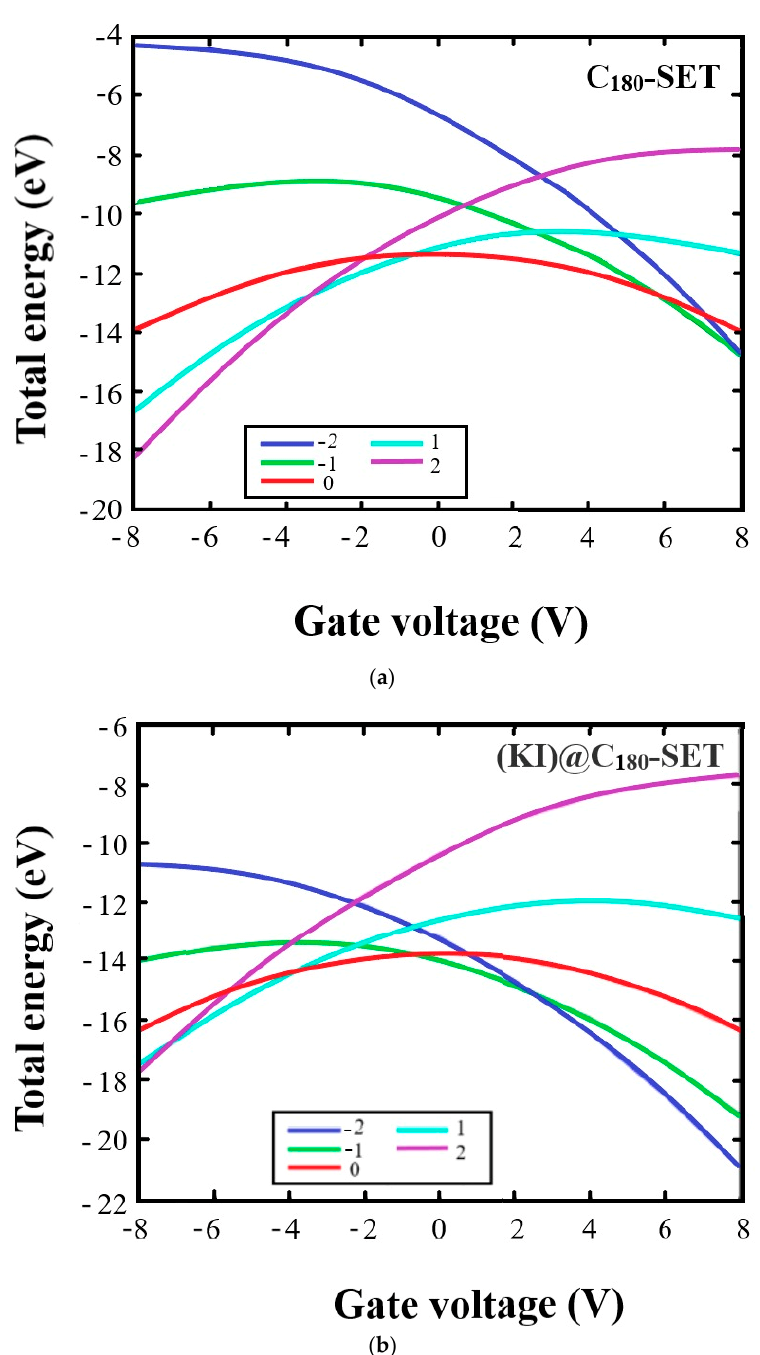
Figure 3. Dependence of total energy from the gate voltage for SETs based on: ( a ) C 180 ; ( b ) (KI)@C 180 . Different charged states of the molecule are shown with different colored curves: blue ( − 2), green ( − 1), red (0), turquoise (1), and violet (2).